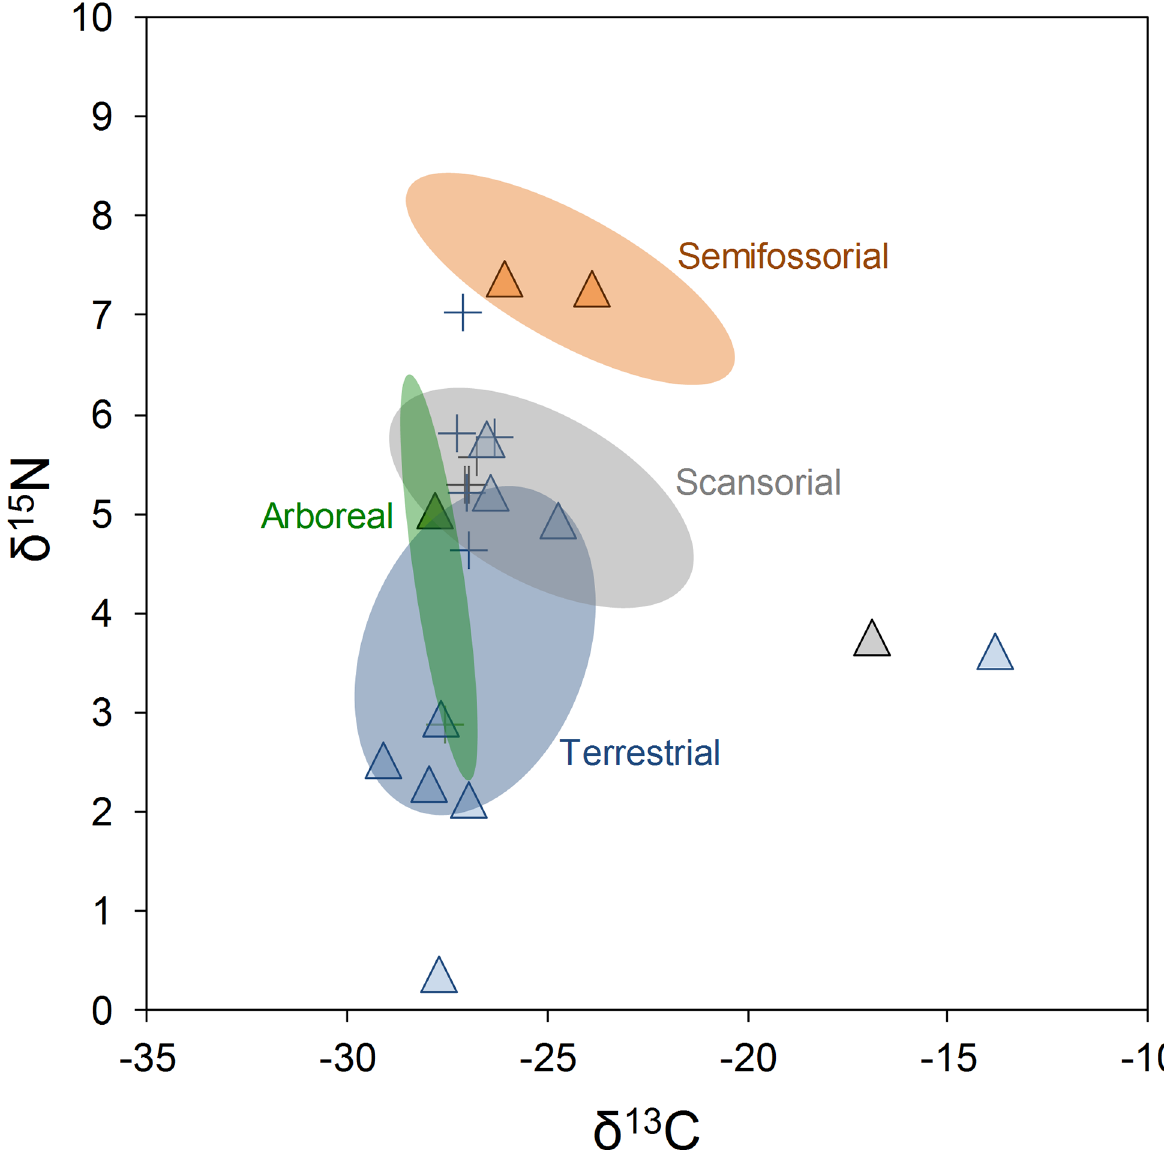
Fig 3. Standard isotope ellipses (SEA C ) from different groups of locomotor habit in communities of small mammals in the Atlantic forest.